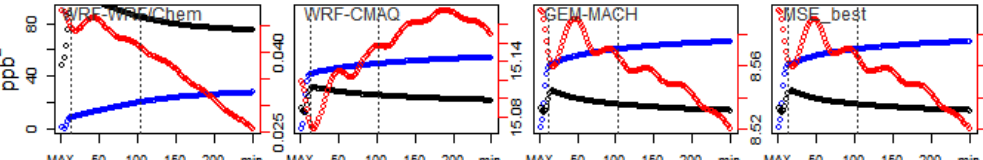
Figure 8. Evolution of error components (red: bias; blue: variance; black: covariance) as a function of model complexity. Complexity increases from right (min) to left (MAX) and is calculated as the temporal scale of the resolved process using the kz filter on the modelled signal: kz(i,5), i = 2 ,...,